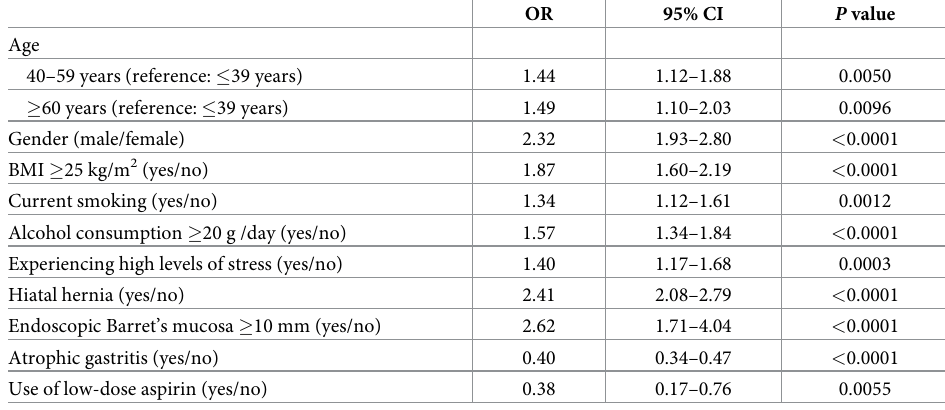
Table 3. Multivariate analysis of the factors associated with erosive esophagitis compared to the control group.